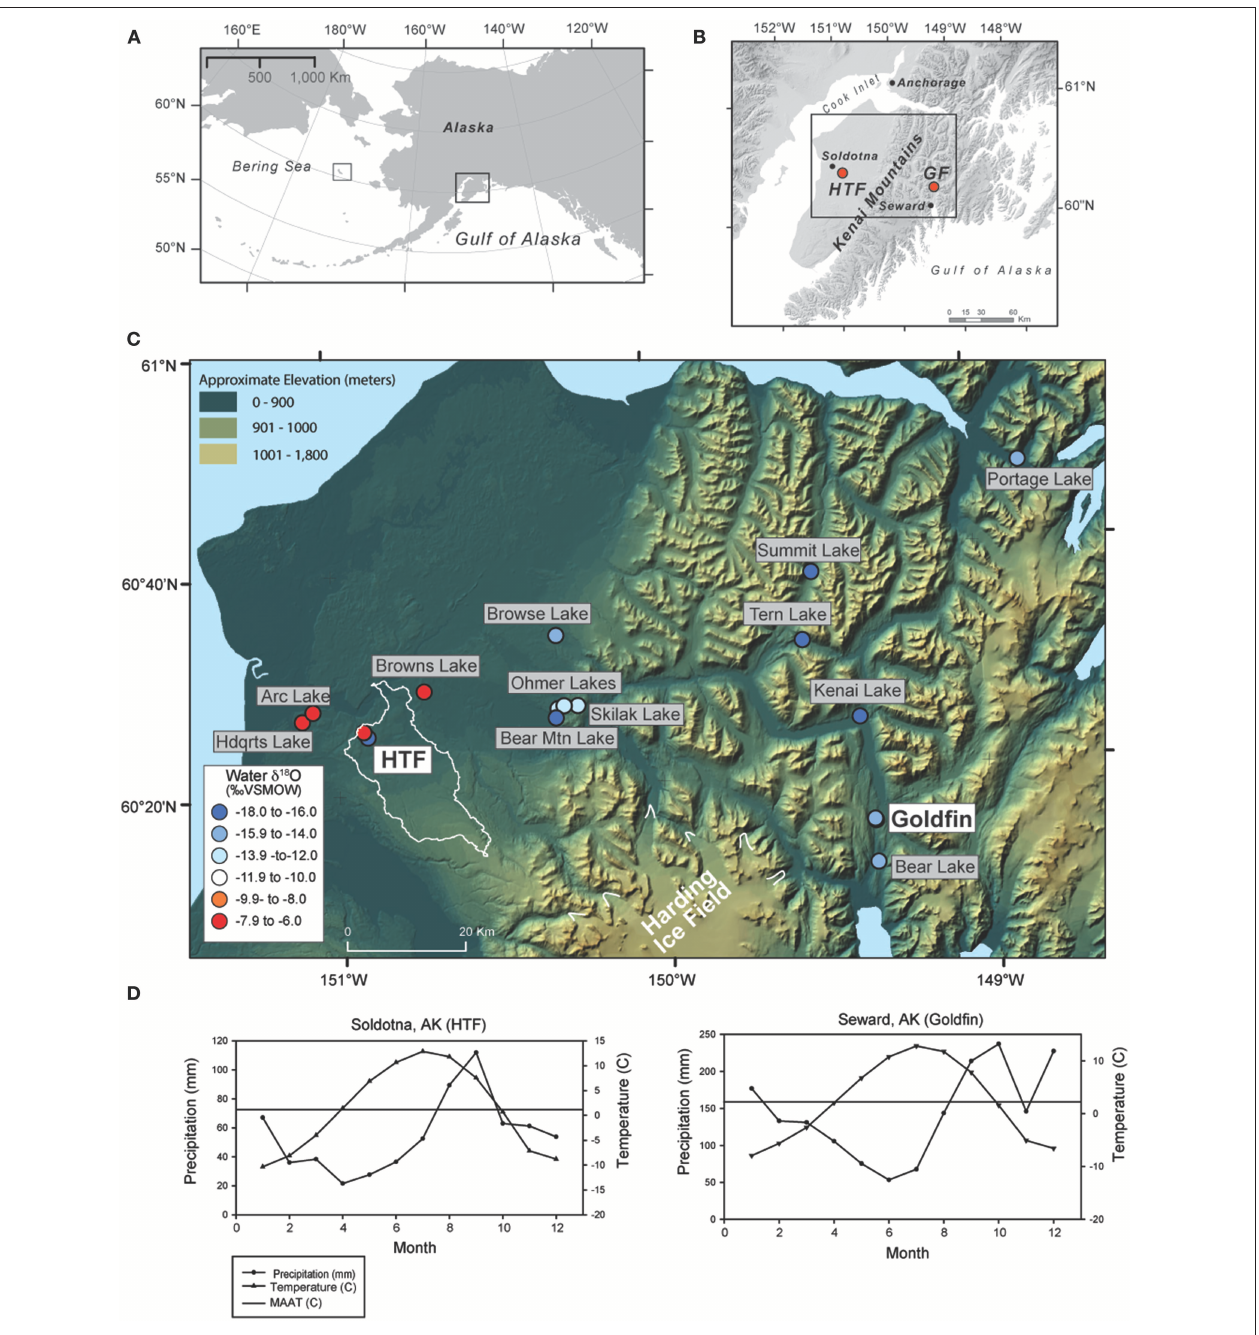
FIGURE 1 | Maps of the Kenai Peninsula (A) relative to the North Pacific and Alaska (right black square), also showing the location of St. Matthew Island in the Bering Sea (left black square) (B) with Horse Trail fen (HTF) and Golfin (GF) study sites on a gray shaded DEM, (C) and lake and peat water sample locations on a color DEM; circle colors indicate water δ 18 O values and the light outline around HTF indicates the surface watershed outside the glacial limits of the Kenai icefield, (D) precipitation and temperature averages for the closest weather stations to Horse Trail fen and Goldfin (1981–2010 average).